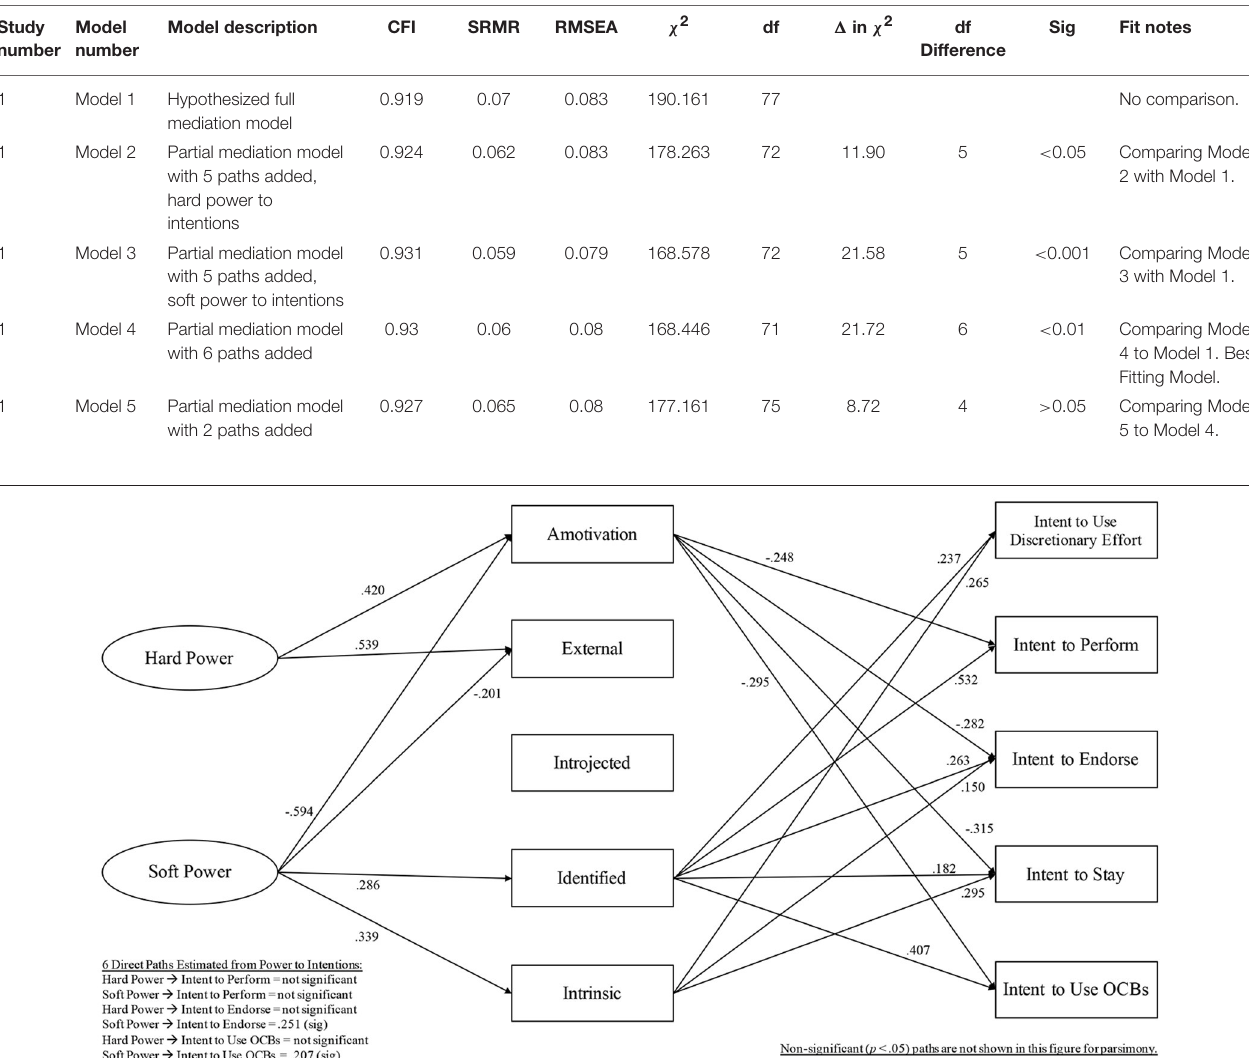
TABLE 2 | Chi-square significance testing for comparison of structural equation model fit.